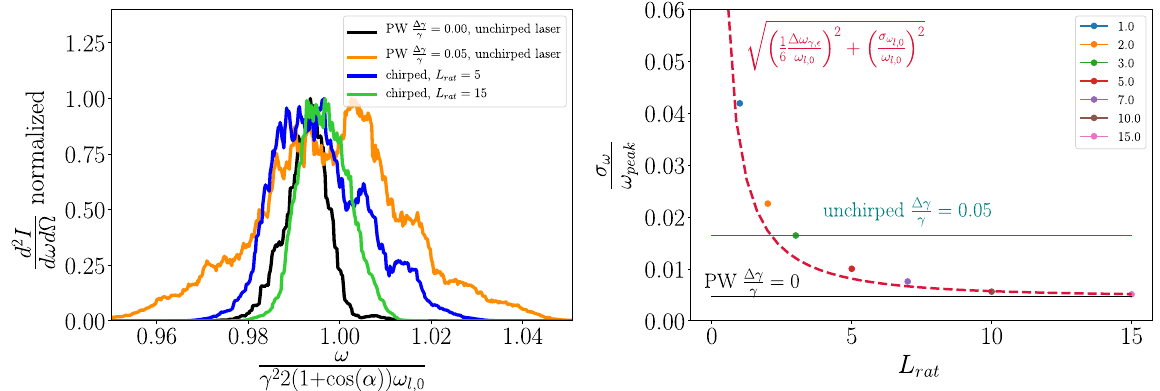
FIG. 5. Calculated on-axis spectra for a circularly polarized laser pulse with ω l; 0 ¼ 1 . 77 × 10 15 [ 1 ¼ 30 × 10 − 4 ½ cm (cid:2) and α ¼ 52 . 8 deg, and electron parameters N W 0 h γ i ¼ 10 3 , with an energy spread Δ γ with two Gaussian beams. Right: the bandwidth of the emitted spectrum as function of L bandwidth of the emitted spectrum. The factor of 1 limit of Eq. (23) is visible, as the bandwidth of the emitted spectrum cannot be lower than the PW monoenergetic electron bunch